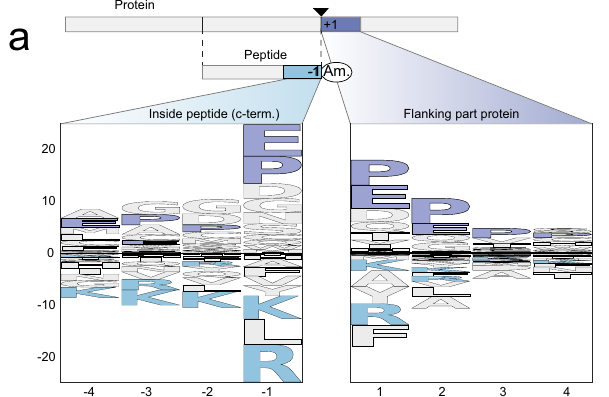
Fig.7|Logoandenrichmentplotofnon-Glycineamidatedpeptides.a Logoplot calculated for non-Glycine amidated peptides with a PPV score above 0.01 (fore- ground: non-Glycine amidated peptides, background: all non-Glycine peptides). LeftsideconstitutestheC-terminalendofthepeptide(non-Glycineamidated),and right side the fl anking protein region. b Bar plot showing the individual or